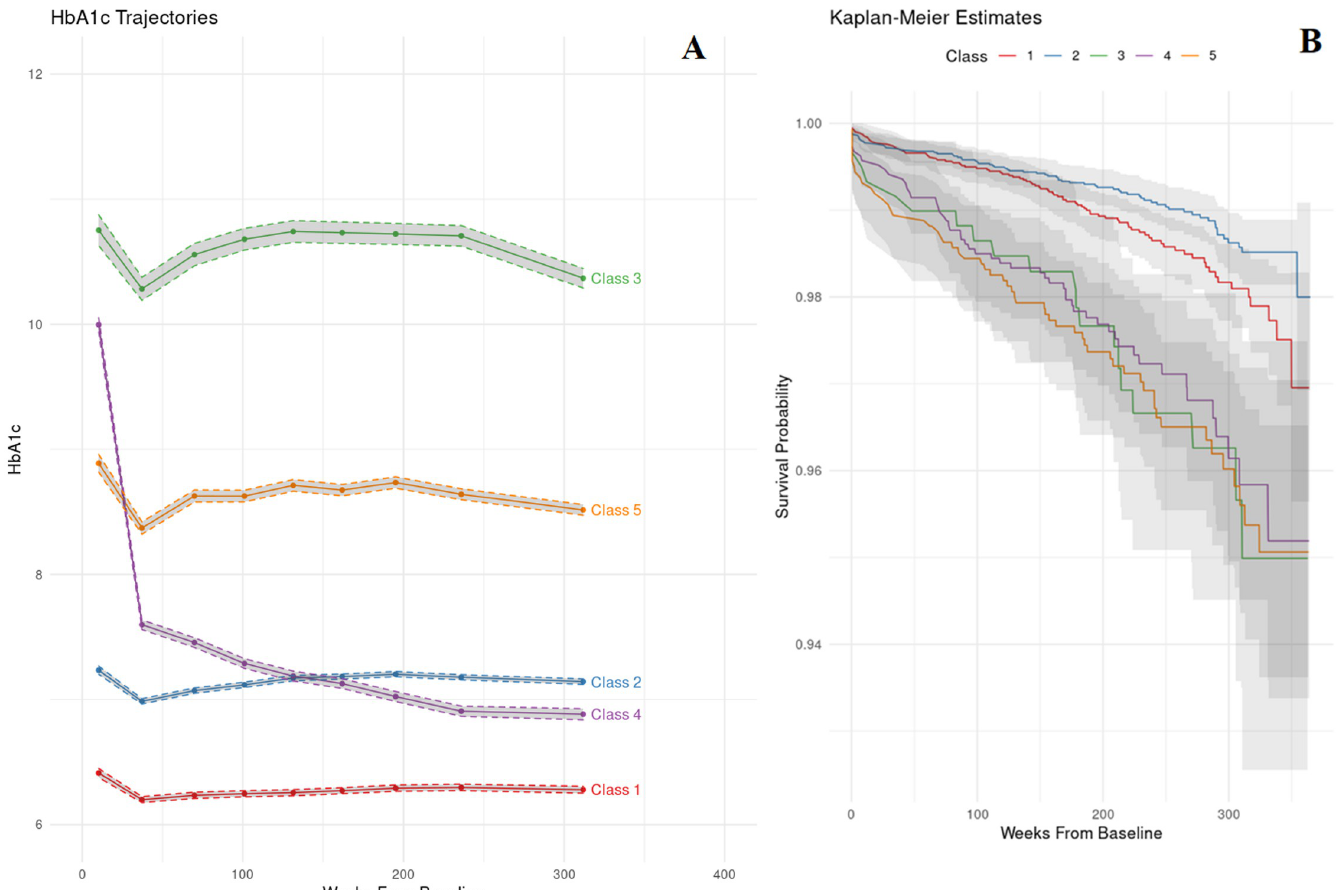
Fig 1. (A) HbA1c trajectories of the 5 classes. (B) Kaplan-Meier curves of the 5 classes.